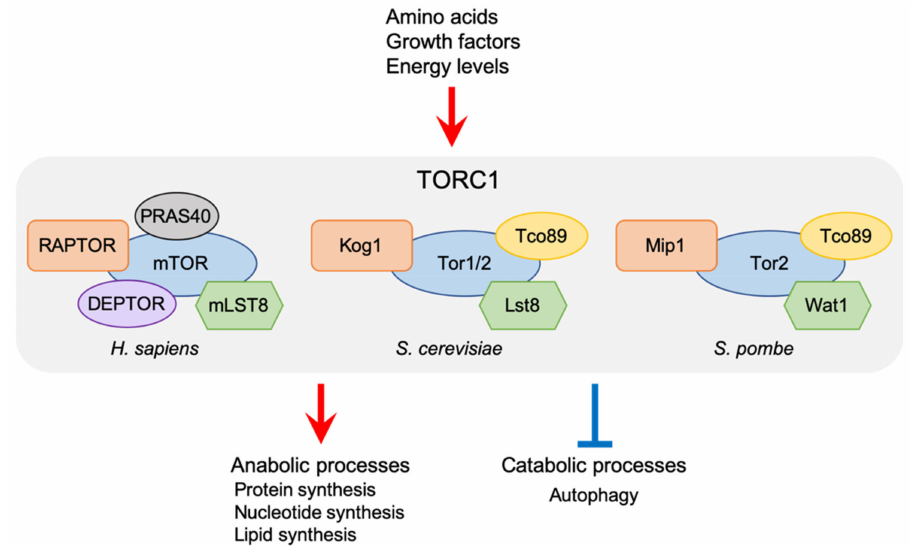
Figure 1. Cellular function of TORC1 and its subunits in humans, Saccharomyces cerevisiae , and Schizosaccharomyces pombe . RAPTOR and mLST8 are conserved from yeast to humans. TORC1 regulates cellular growth and metabolisms in response to various stimuli by modulating both anabolic and catabolic